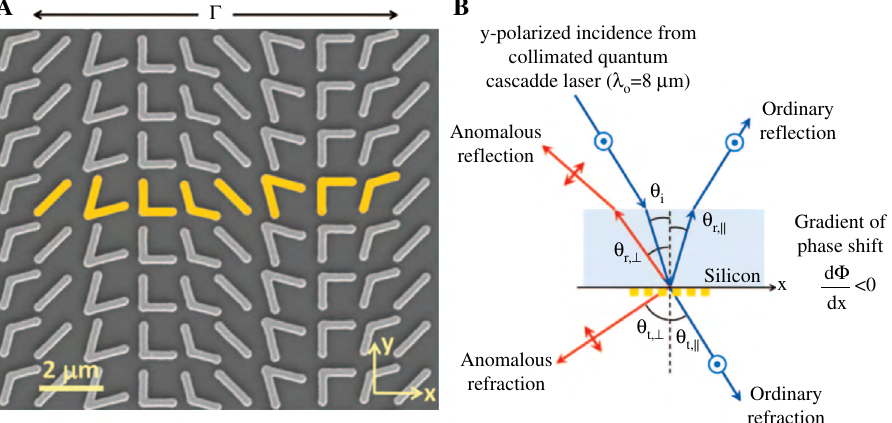
Figure 3 (A) SEM image of a plasmonic antenna array fabricated on a silicon wafer. The unit cell of the metasurface comprises eight gold V-shaped antenna with a periodicity Γ = 11 μ m in the x direction. (B) A gradient of interfacial phase jump d f /d x provides an effective wavevector along the interface that can bend cross-polarized transmitted and reflected light into arbitrary directions. Adapted from Ref.